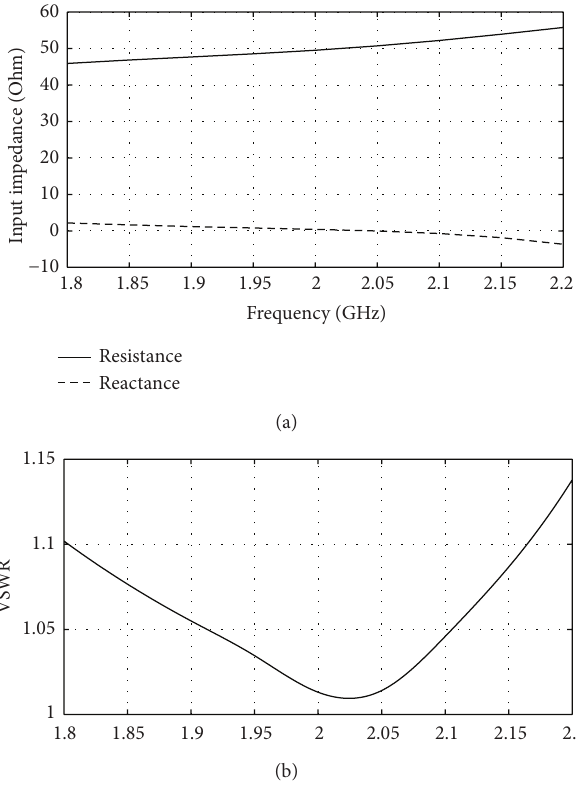
Figure 10: Variation of (a) the input impedance and (b) VSWR of a split coaxial balun terminated by a balanced 75 Ω -load with the = 8 mm, 𝐷 = 3.5 mm, 𝐷 = 2.4 mm, 𝐿 = frequency; 𝐷 1 in 2 in 1 out out = 3.44 cm, 𝐿 = 6.34 cm, 𝐿 = 3.82 cm, 𝐿 = 6.72 cm, 𝐿 2 out 1 in 2 in 𝑡 = 40 ∘ 3.8 mm, and 𝜃 Figure 9: Variation of (a) the input impedance and (b) VSWR of a 𝑠 split coaxial balun excited at the coaxial side and terminated at the twin side by 75 Ω load with the diameter of the inner conductor of = 8 mm, 𝐷 = the split section of the balun; 𝑓 = 2.0 GHz, 𝐷 1 in out = 6.72 cm, 𝐿 = 3.44 cm, 𝐿 = 6.34 cm, 𝐿 = 3.5 mm, 𝐿 1 out 2 out 1 in 2 in = 3.8 mm, and 𝜃 = 40 ∘ . 3.82 cm, 𝐿 𝑡 𝑠